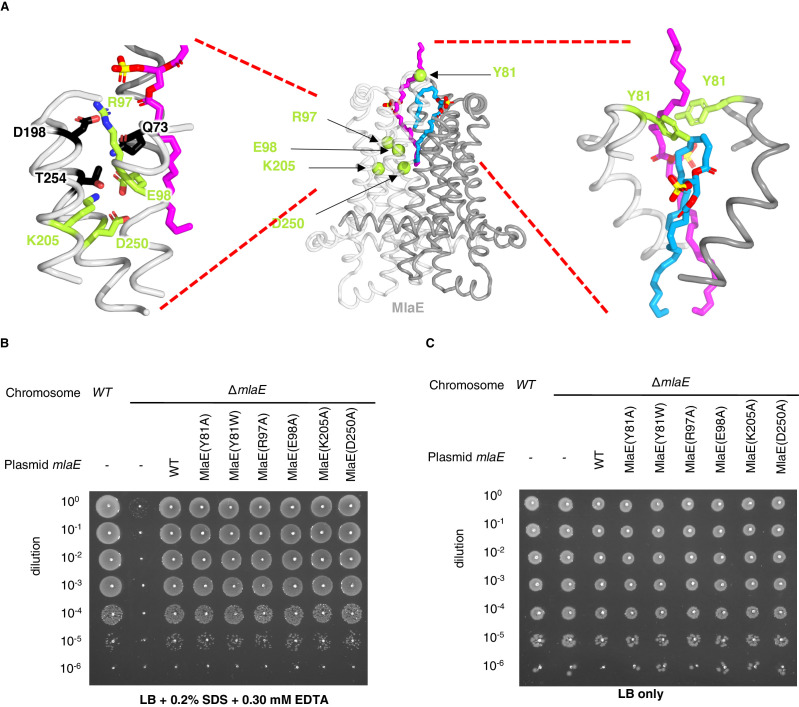
Point mutations in MlaE.(A) Center, MlaE dimer (gray ribbons) with sites of mutations indicated by spheres (lime), and the two bound lipids (magenta and blue sticks). Left, zoomed in view of the salt bridges formed by residues Arg97, Glu98, Lys205, and Asp250 (lime sticks), part of a larger polar interaction network including Gln73, Asp198, and Thr254 (black sticks). Right, zoomed in view of interactions between Tyr81 (lime) and bound lipids (blue and magenta). (B) Tenfold serial dilutions of the indicated cultures spotted on LB plates containing SDS and EDTA at the concentrations indicated and incubated overnight. The mlaE knockout grows poorly in the presence of SDS+EDTA, but can be rescued by the expression of WT MlaE or MlaE mutants. (C) Same as in (B), but plated on LB only.